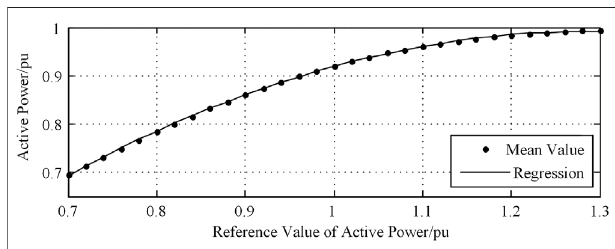
FIGURE 3 | The relation between reference value and mean value of controllable photovoltaic (PV)